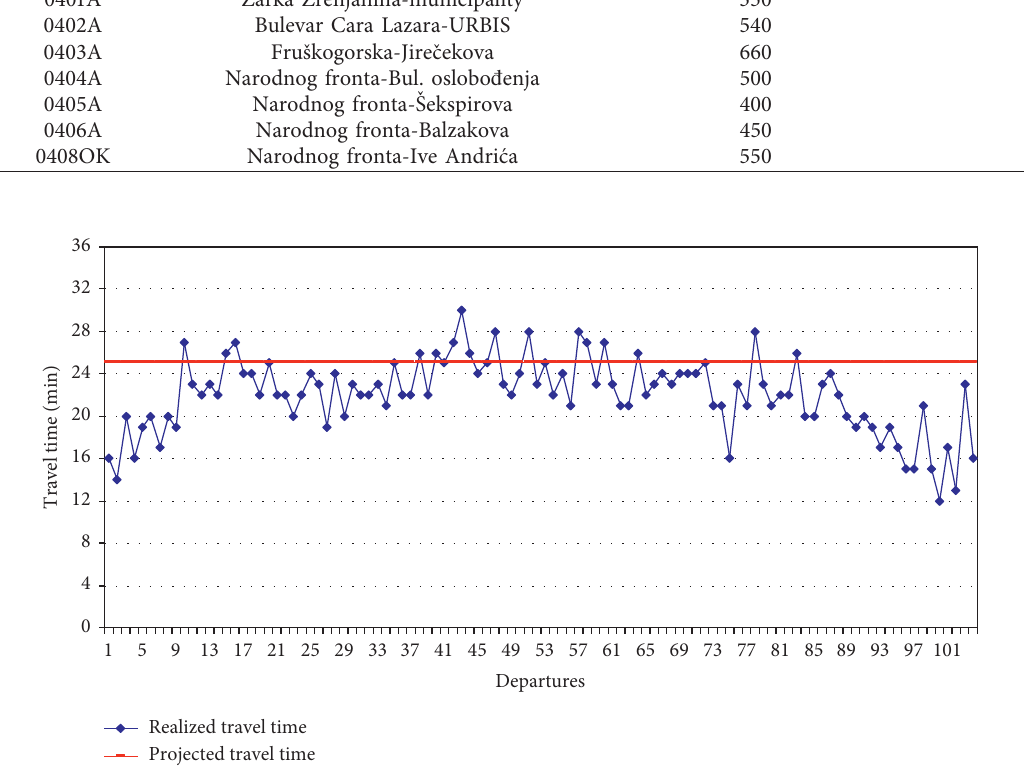
Figure 5: Travel time by individual departures from direction